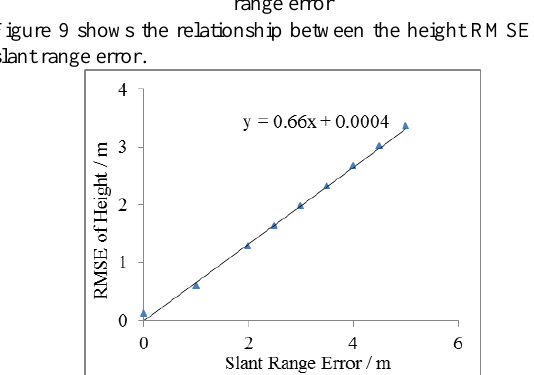
Figure 9. Relationship between the height RMSE and slant range